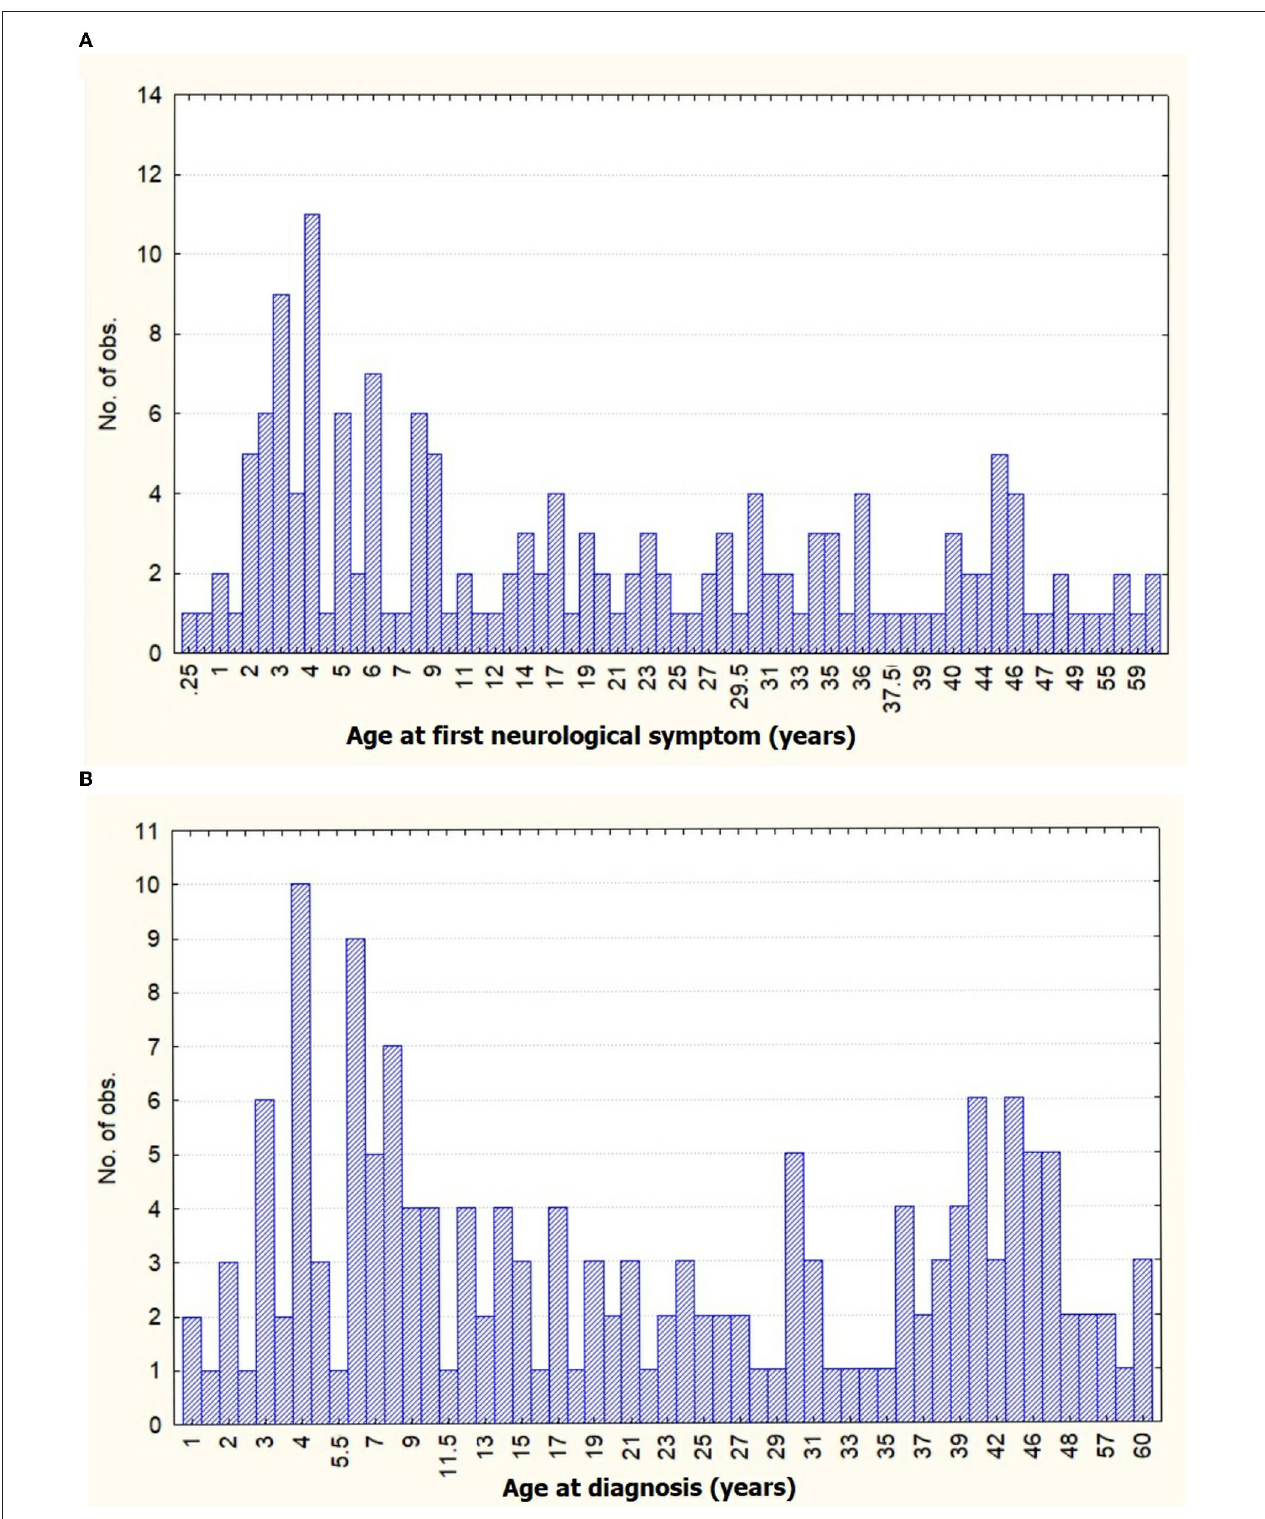
FIGURE 1 | Distribution graph of age frequency with (A) age at first neurological symptom and (B) age of diagnosis of moyamoya angiopathy (MMA) in our cohort.